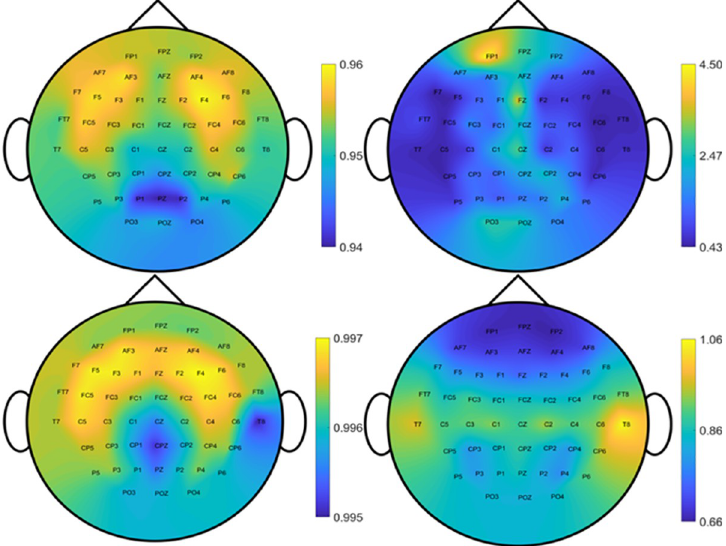
Fig 5. The distribution of TOC, EPD, Correlation and MAE [mV/m] on EEG position with C-60 model on the surface